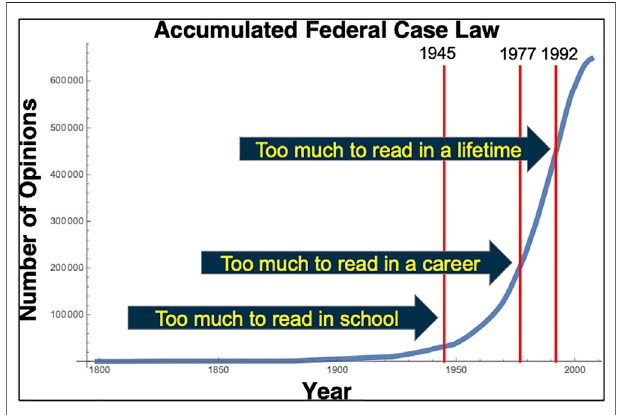
FIGURE 1 | The monotonic accumulation of judial opinions over